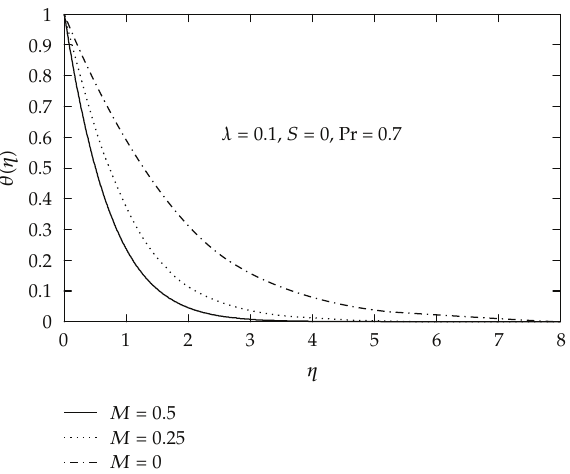
Figure 2: Variation of temperature θ (cid:6) η (cid:7) with η for several values of the curvature parameter M when λ (cid:9) 0 . 1, S (cid:9) 0, and Pr (cid:9) 0.7.